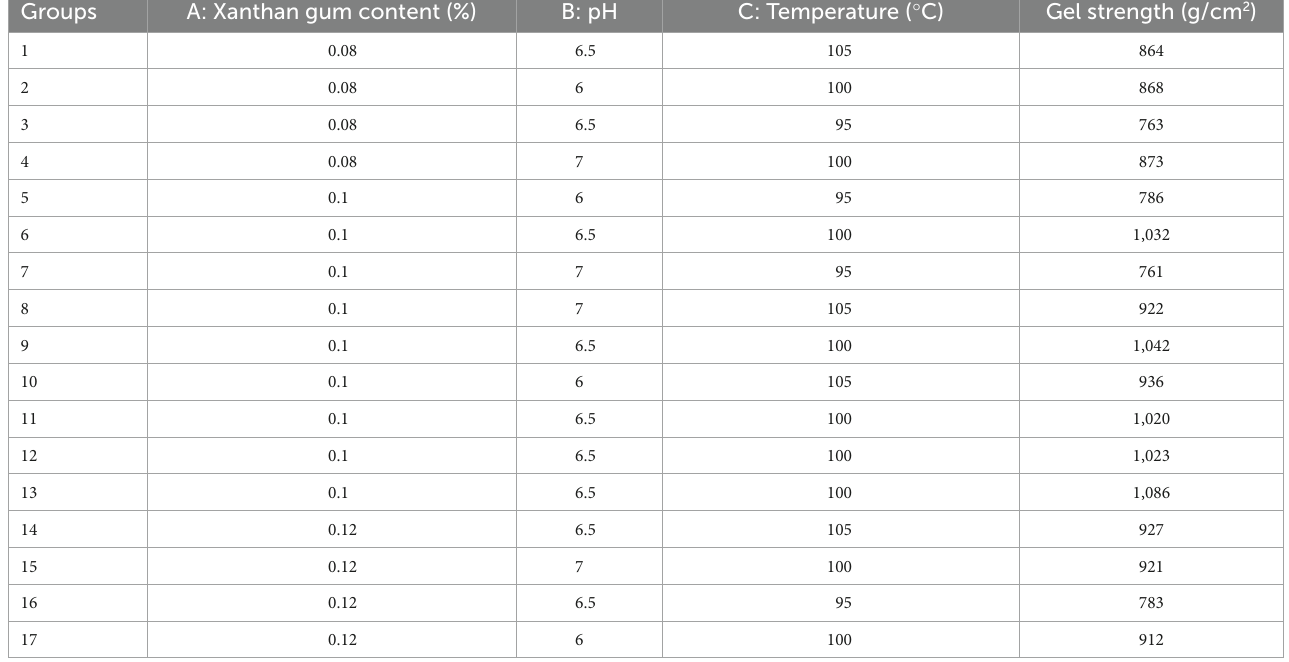
TABLE 1 Results of single-factor